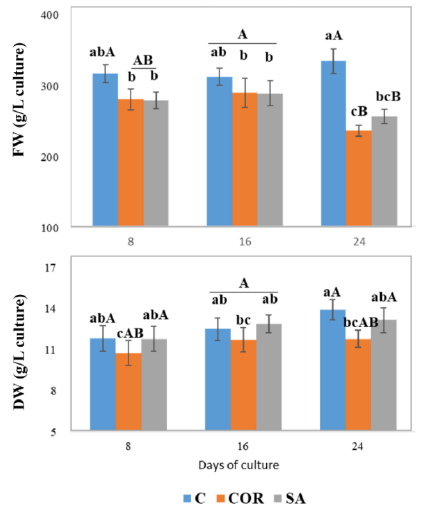
Figure 6. Time courses of biomass production (measured as fresh and dry weight) of T. baccata cell suspensions cultured for 24 days in the production medium in control conditions (C) or with the addition of 1 μM COR (coronatine) or 150 μM SA (salicylic acid). In all cases, the inoculum consisted of 300 g/L of cells. Data represent average values from three separate experiments ± SD. Lowercase letters indicate significant differences ( p < 0.05) within treatments between experimental time points. Capital letters indicate significant differences ( p < 0.05) between treatments within the same experimental time point. The statistical differences were evaluated according to Tukey’s honestly significant different test.